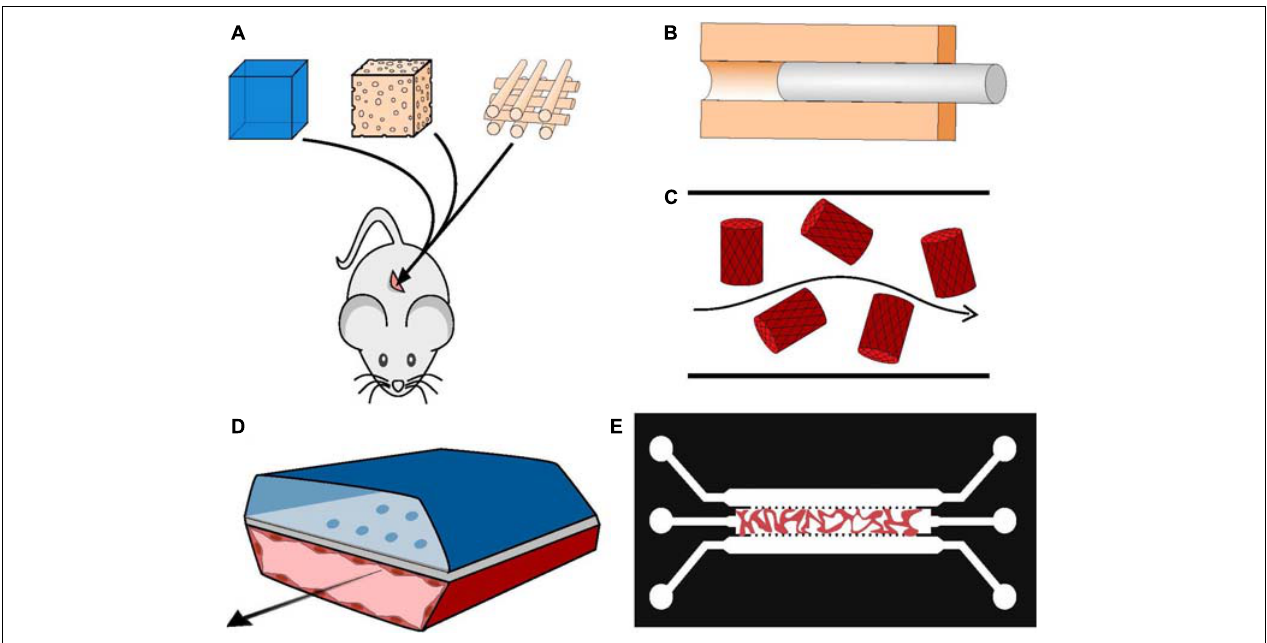
FIGURE 2 | Manufacturing vascularized BM systems. (A) Implantation of mesenchymal and endothelial cell-loaded hydrogels, sponges or printed scaffolds subcutaneously in immunodeficient mice. The resulting vasculature will be anastomosed to mouse host vasculature. (B) Generation of a hollow tube in a 3D matrix through the use of sacrificial material; the channel walls can be seeded with ECs afterward. (C) Cell-loaded hydrogel islets are seeded with a layer of ECs and placed in a microfluidic channel with a continuous flow, forming an inverted vascularized system (Khan et al., 2012). (D) Formation of organ-on-chip systems with two parallel hollow tubes separated by a porous membrane, one containing tissue specific cells and the other coated with ECs and perfused with medium to serve as a functional vascular system (Huh et al., 2013). (E) Generation of self-assembled and perfusable vascular network in a microfluidic chip (see dedicated Box 1